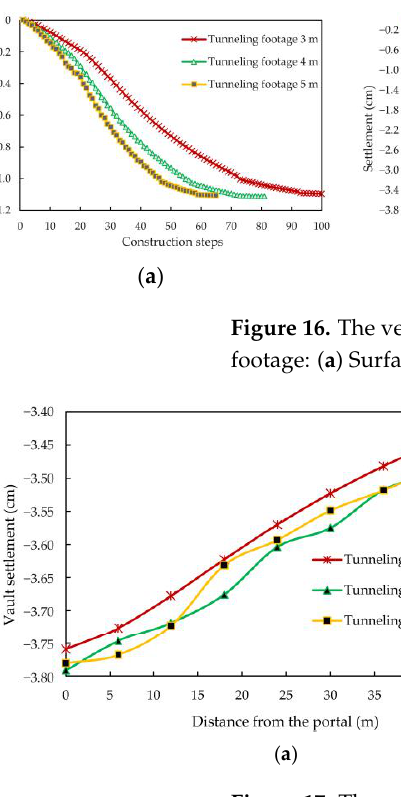
Figure 17. The vertical displacement of the main line tunnel and ramp vault at different distances from the tunnel portal: ( a ) Main line tunnel; ( b ) Ramp.